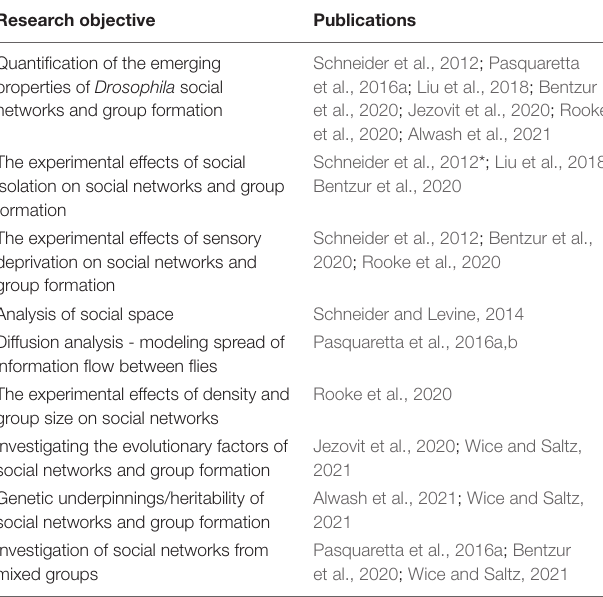
TABLE 3 | A summary of the research objectives and hypotheses tested in all published-to-date Drosophila social network studies. Research objective